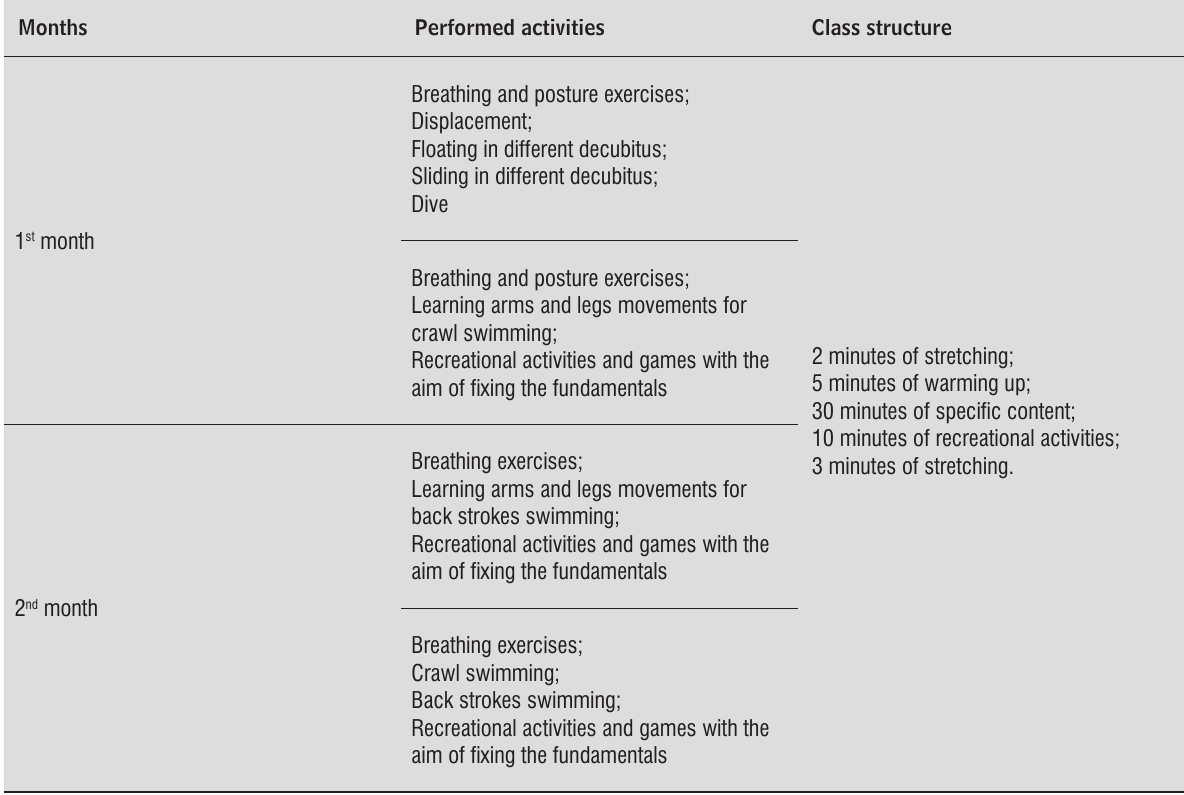
Table 1 - Description of the experimental training applied to the experimental group in 24 sessions